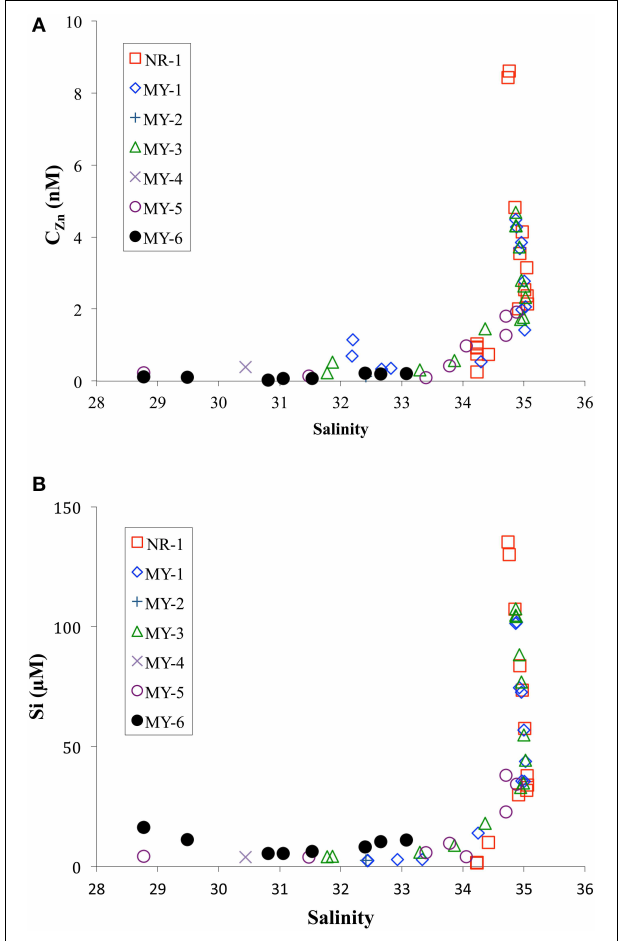
FIGURE 5 | Comparison of practical salinity with (A) C Zn and (B) Si in the northeastern Indian Ocean (NR-1) and the Andaman Sea